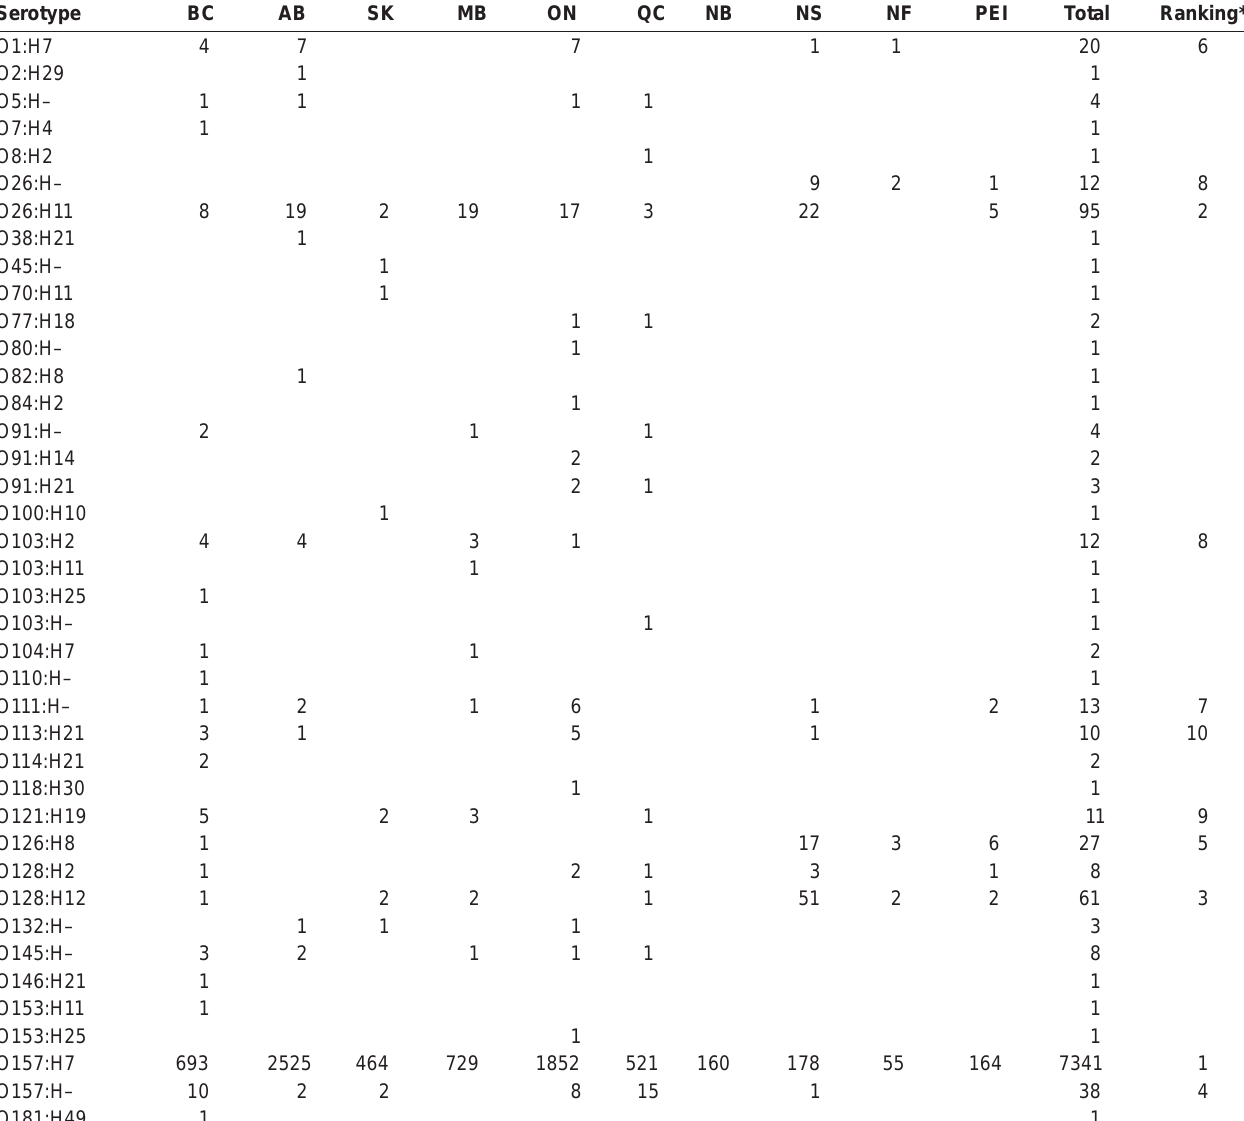
TABLE 5 Geographical distribution of verotoxigenic Escherichia coli serotypes from human sources in Canada investigated by the Canadian National Laboratory for Enteric Pathogens between 1983 and 2000 Serotype